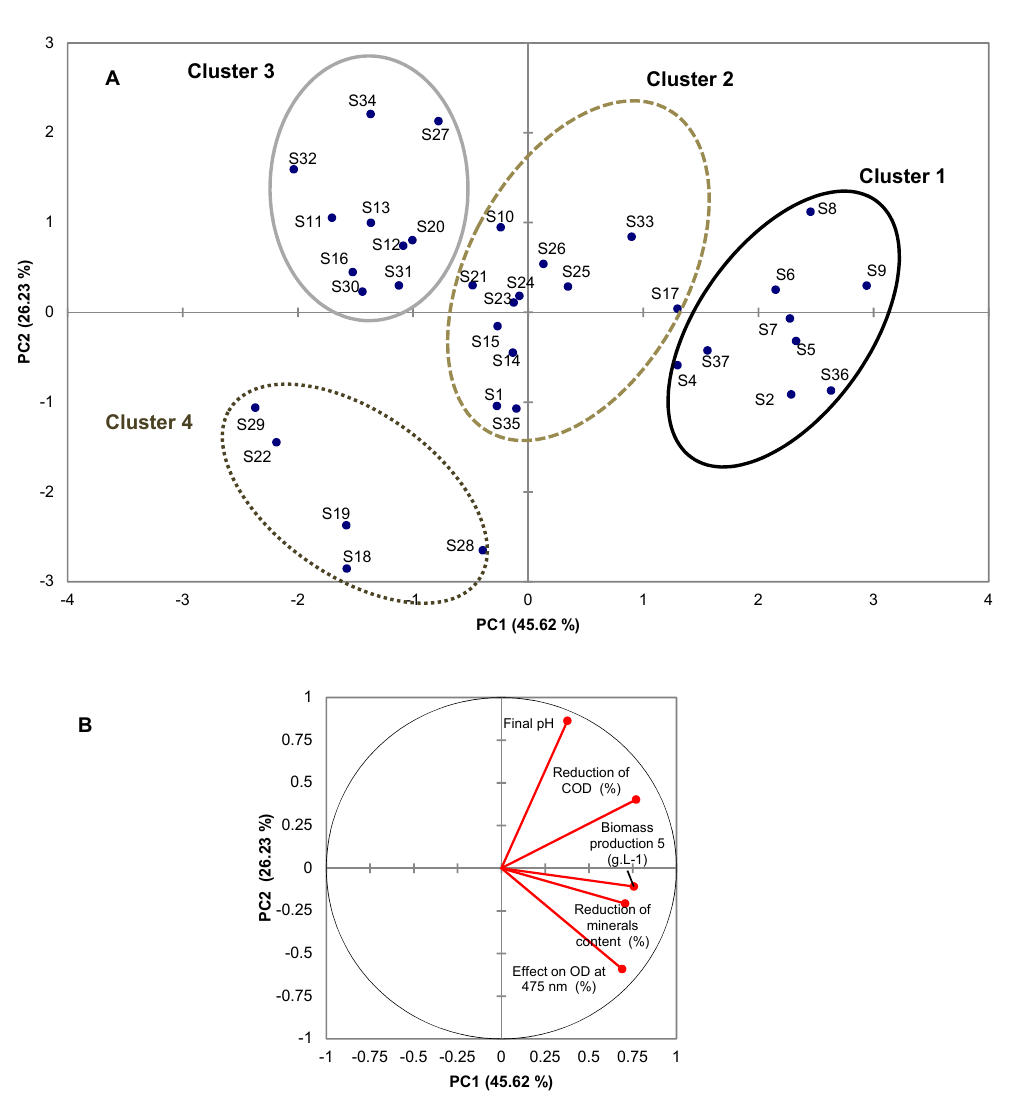
Figure 1. Score plot of PC 2 versus PC 1 ( A , B ) for fungal ability for DSW bioremediation.